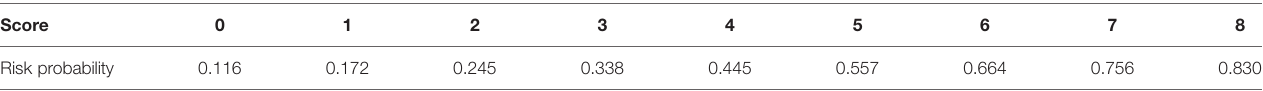
TABLE 5 | Risk of hepatotoxicity according to scores using logistic